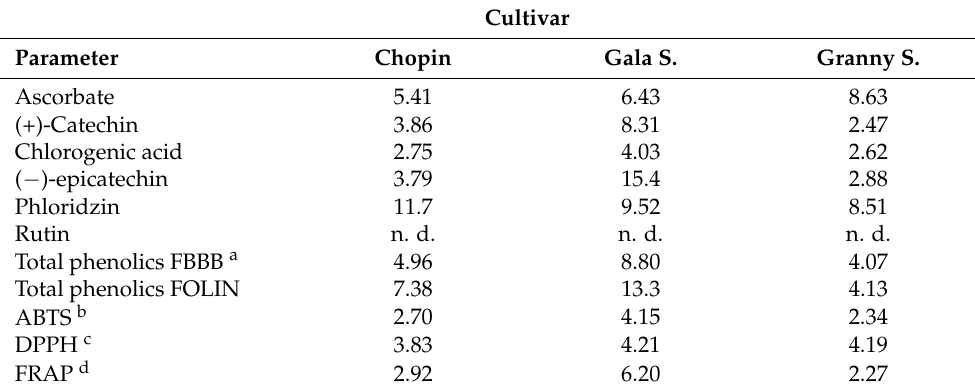
Table 5. Range of differences between the apple peel and flesh (AP/AF) depending on the cultivar and parameter tested. Cultivar Parameter Chopin Gala S. Granny